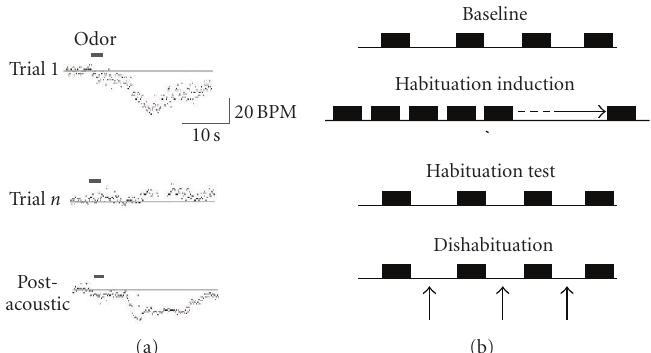
Figure 2: (a) Representative raw recordings of odor-evoked heart rate orienting responses (instantaneous beats/min) in response to odor stimulation before and after habituation, and after presentation of a 108 dB siren. (b) Schematic of experimental design. Odor test pulses (3-4 repeats) were presented with at least 60-second interstimulus intervals to determine mean baseline response magnitude. Then repeated stimuli (20-second ISI) were presented to induce habituation which was tested with 4 spaced stimuli similar to that during baseline (60- second ISI). To induce dishabituation, a 1–2-second siren (upward arrows) was played 10–30 seconds prior to spaced odor